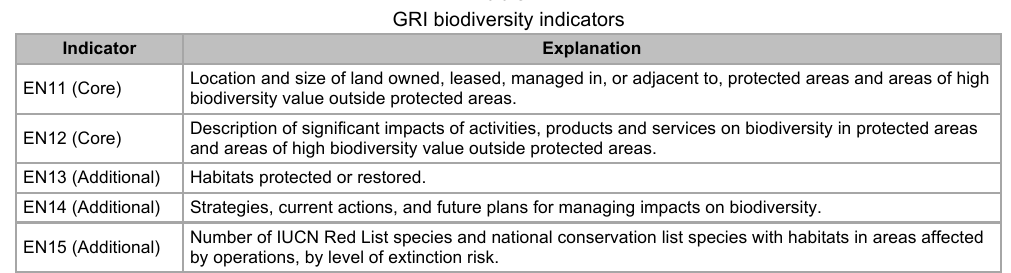
GRI biodiversity